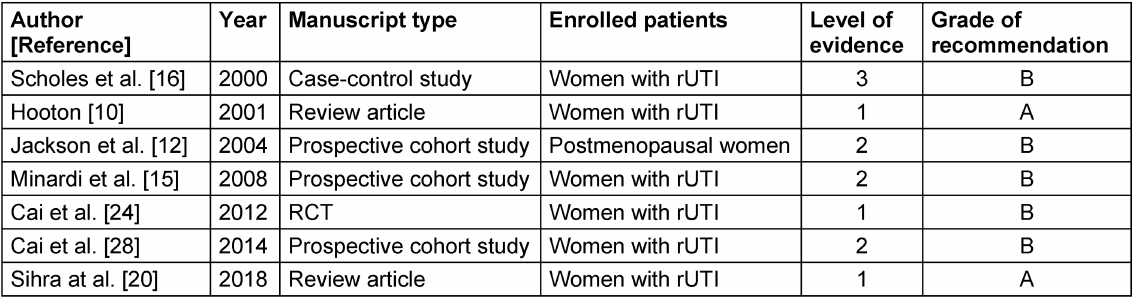
Table 1: Studies evaluated after systematic review